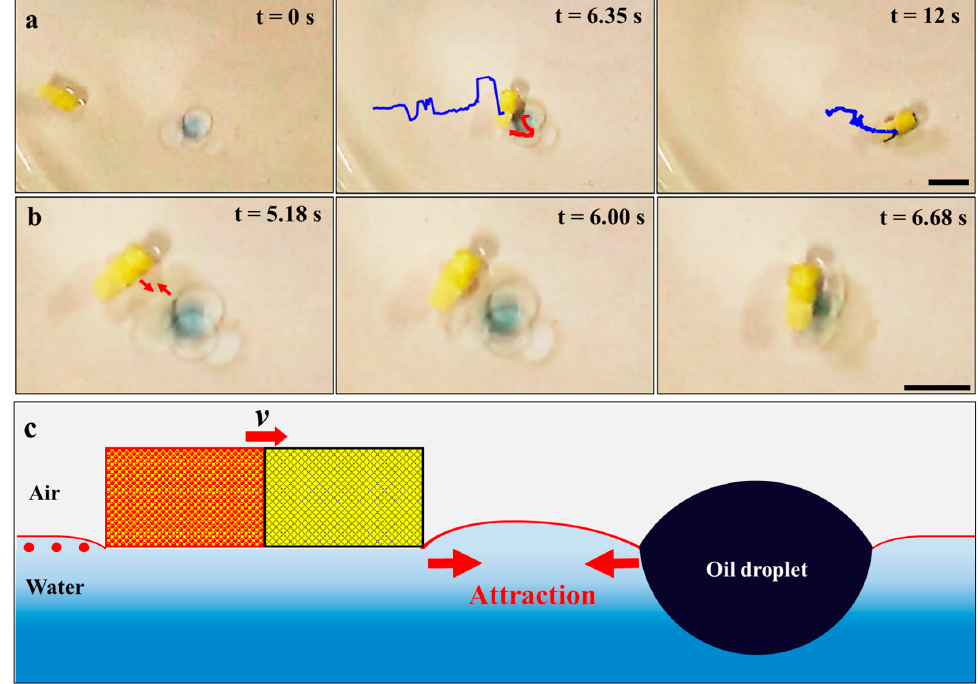
Figure 3. ( a ) Time-lapse images of the oil capture by the Janus foam motor. Red and blue curves represent the trajectories of the oil droplet and Janus foam motors, respectively, suggesting the autonomously approaching, capturing, and transportation of oil droplets by the Janus foam motor. ( b ) Close observation of the attraction between the Janus foam motor and an oil droplet. ( c ) Schematic demonstration of the attractive capillary interaction between the Janus foam motor and oil droplet. Scale bars: 10 mm.